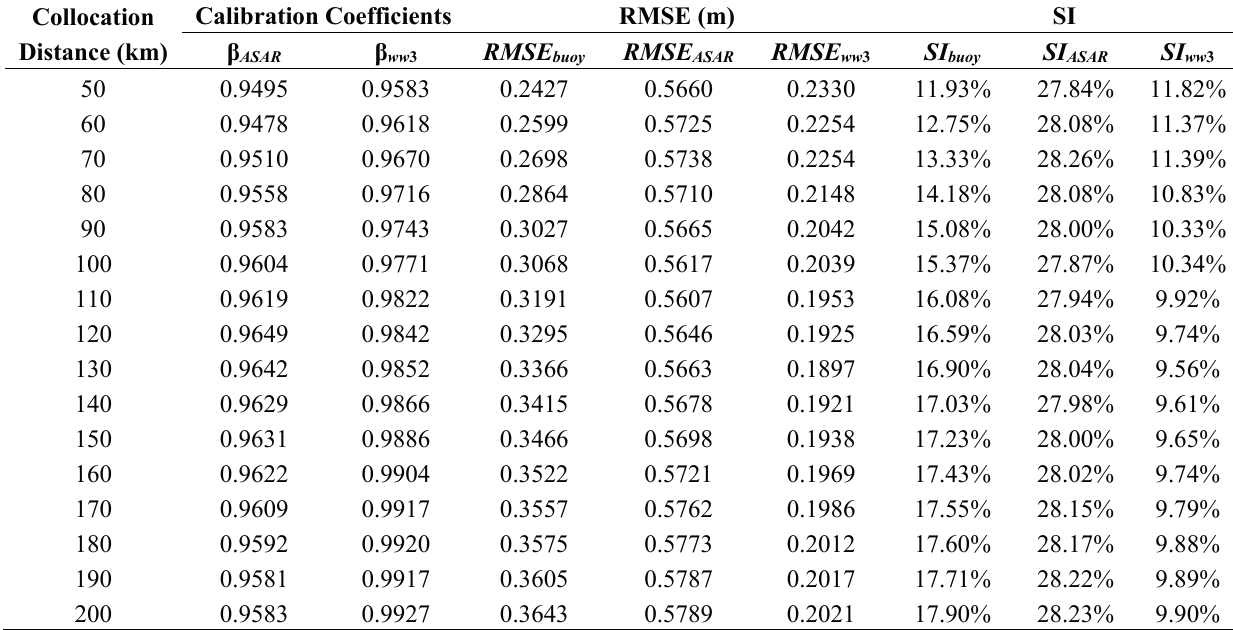
Table 1. Estimates of calibration coefficients, RMSE and SI for the triple collocated SWH datasets from all the 152 buoys, Envisat ASAR and ww3 model hindcasts.